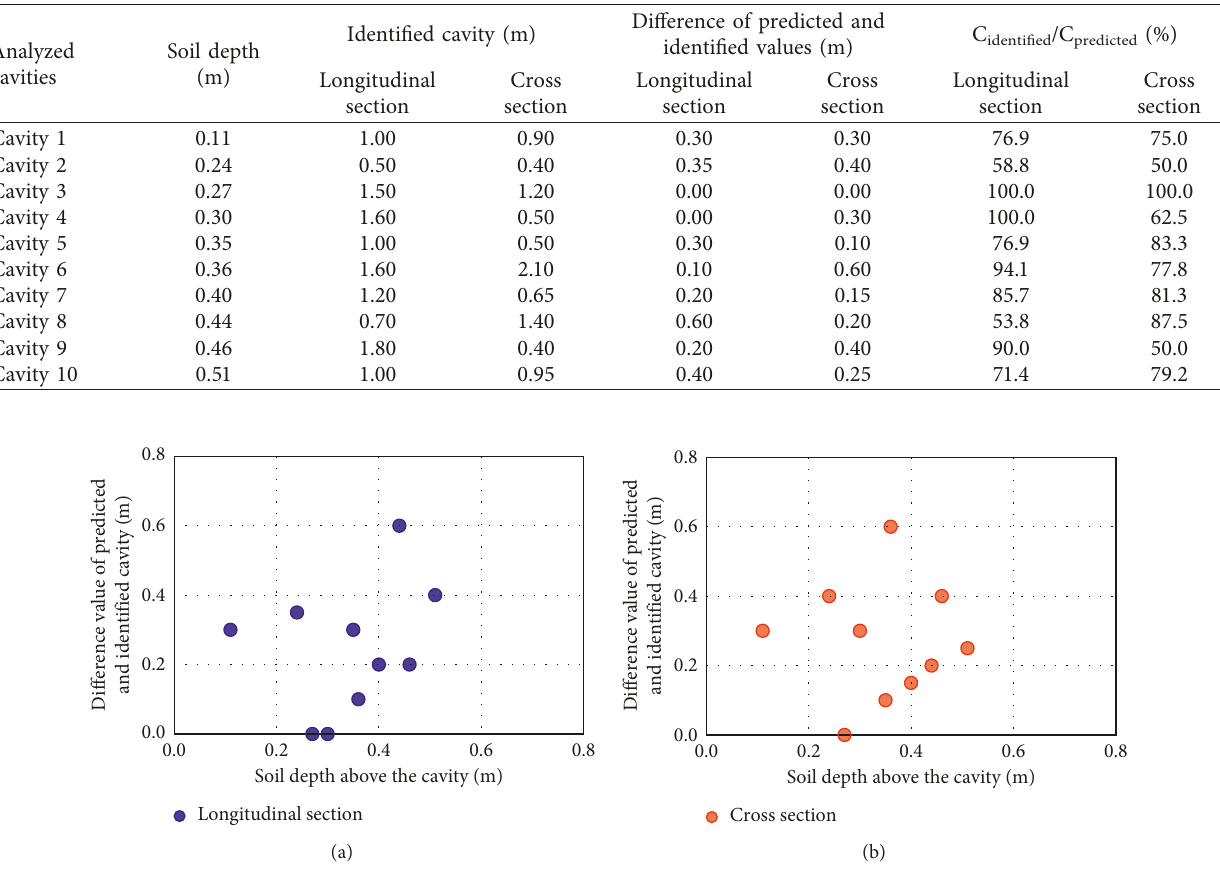
Figure 9: Relationship between the differences in cavity scales according to the soil depth. (a) Longitudinal section. (b) Cross section.